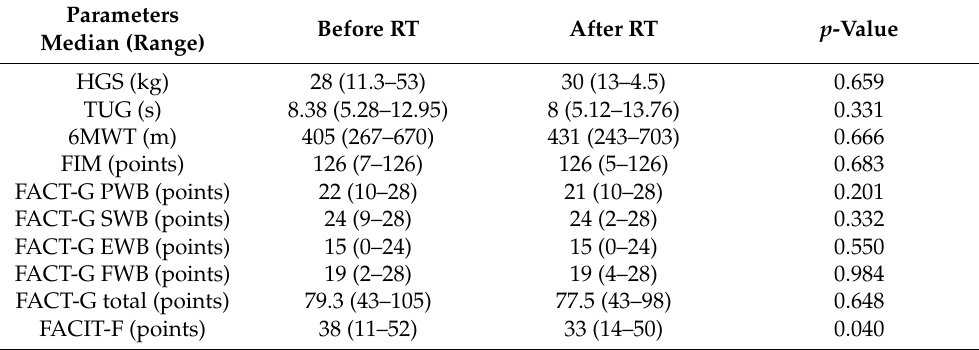
Table 2. Physical fitness, quality of life, and level of fatigue before and after radiotherapy.